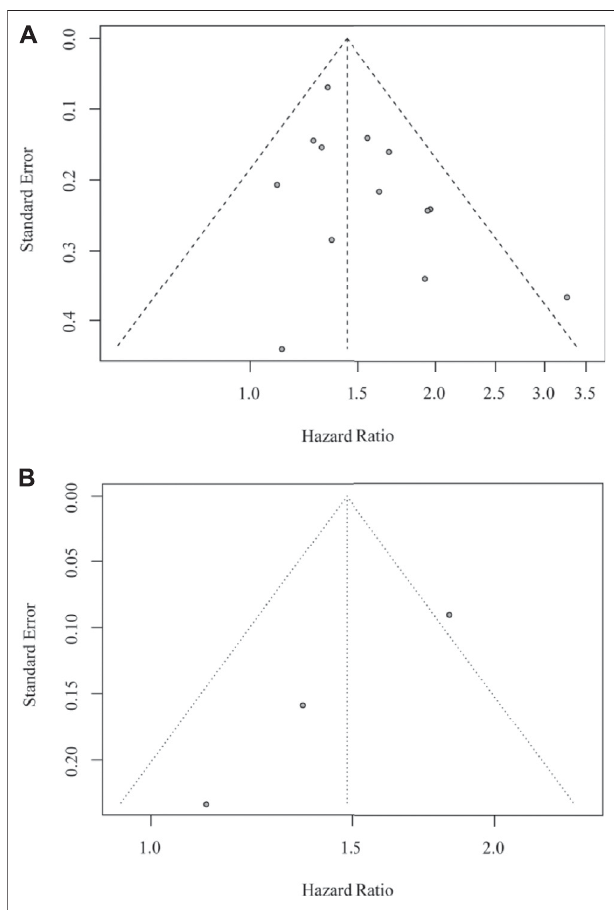
FIGURE 5 | Funnel plot for the study on OS (A) and on PFS (B) of GBM patients.